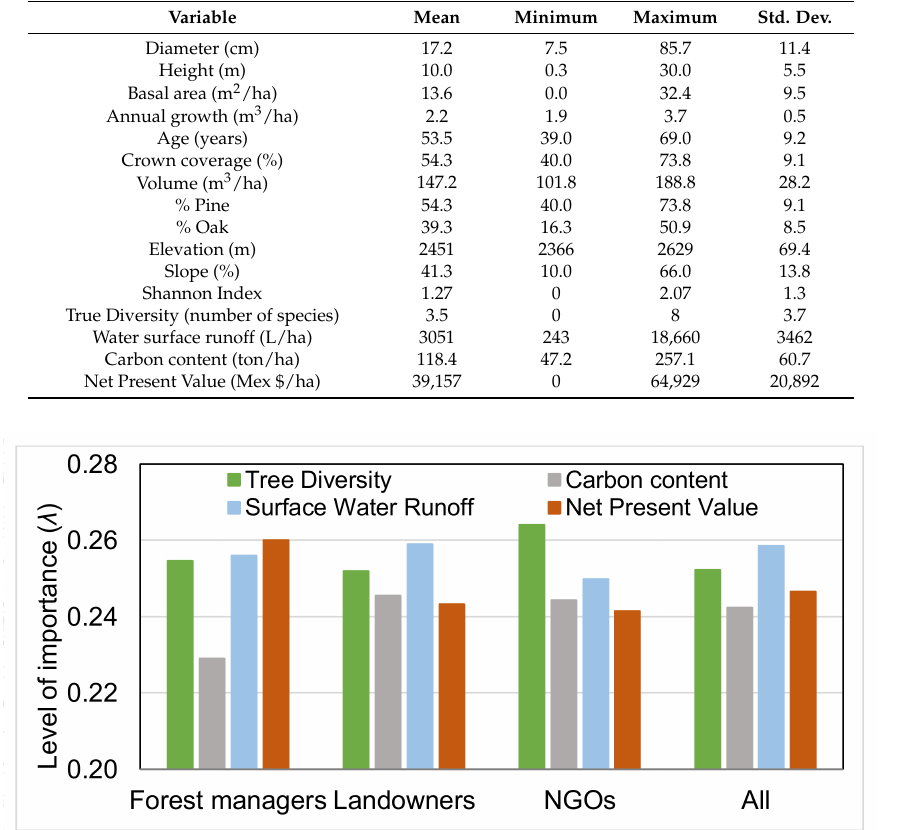
Figure 3. Level of importance of the ecosystem services according to forest managers, landowners, and NGOs. The level of importance has been normalized to make the sum equal to one (Source: Own information and